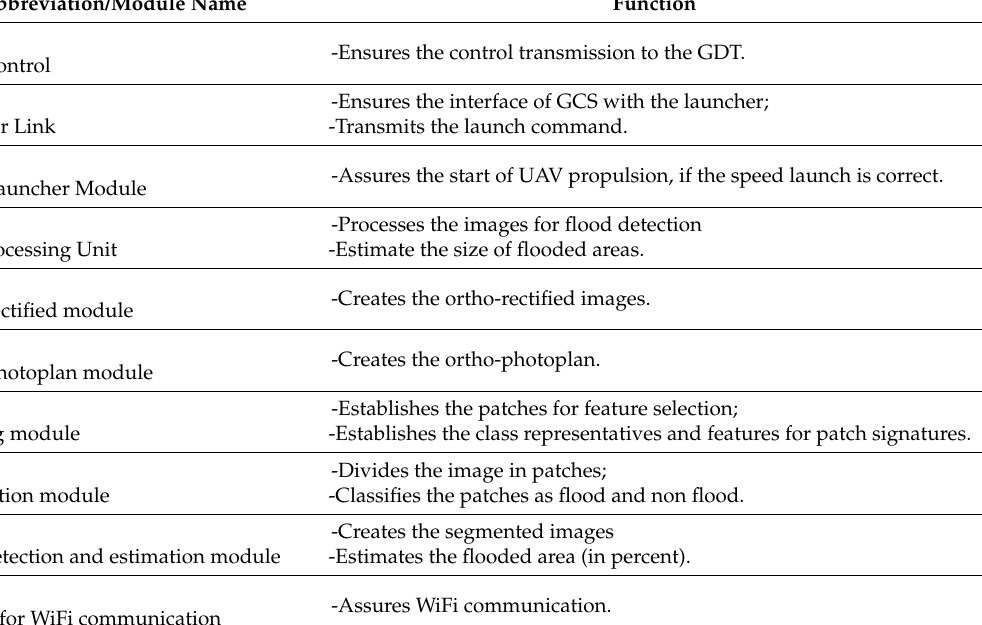
Figure 2. UAV MUROS on launcher.